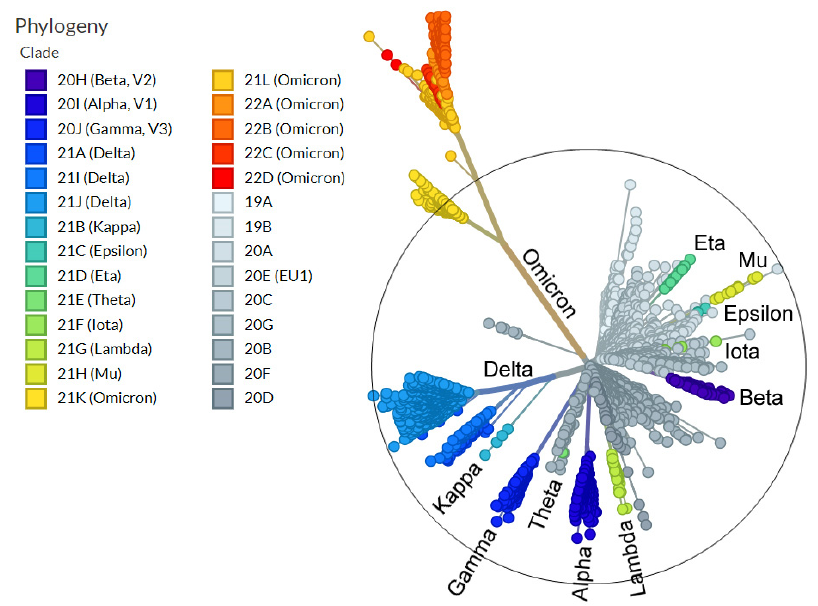
Figure 1. SARS-CoV-2 variants of concern shown on an unrooted phylogenetic tree, the branches of which are scaled by genetic divergence. This image was derived from Nextstrain (https://nextstrain.org/; 15 October 2022) under a CC-BY-4.0 license. The authors of this publication added annotations of the clades to the tree, as well as the centred black circle through the most distant non-Omicron variant.